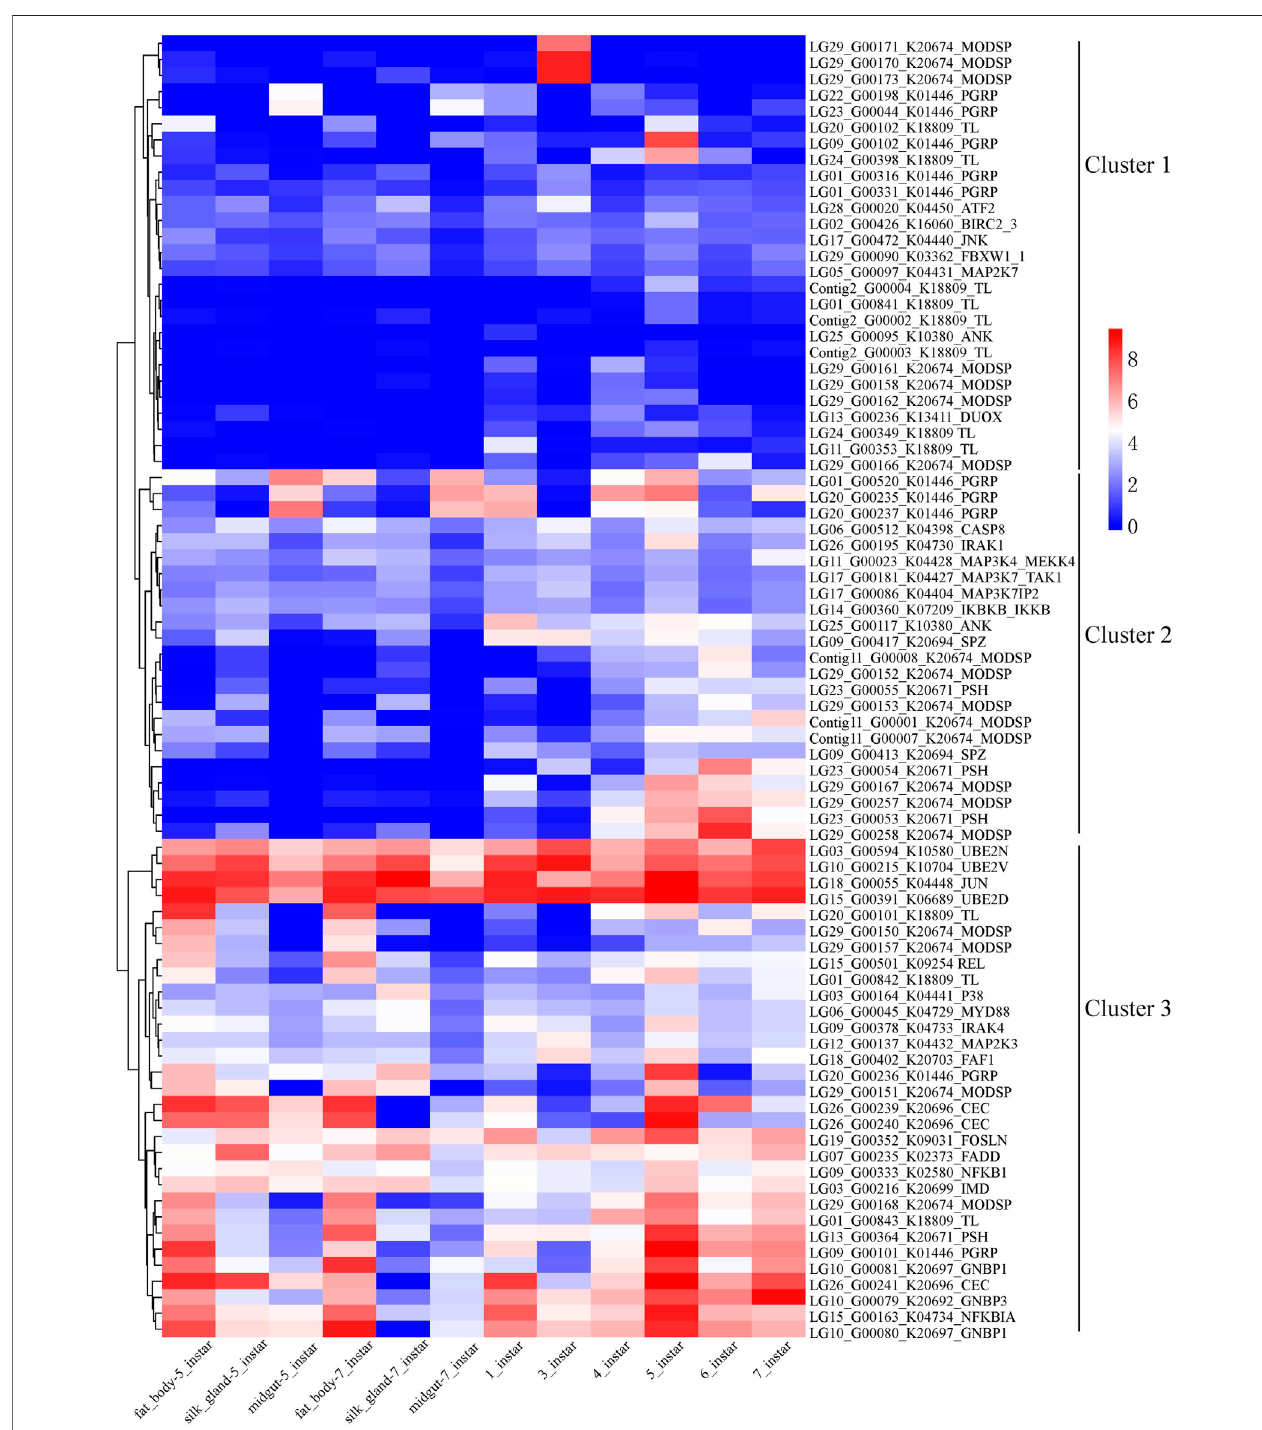
FIGURE 8 | Clustering gene expression pattern of the signi fi cantly expanded genes of the Toll and IMD signaling pathways. Note: Each column represents one sample,eachrowrepresentsonegene.AlltheFPKMvaluesofgenesinthepathwayweretransformedwithlog2,andthennormalizedintoZ-scoresalongtherows.The log2 values were color-coded as shown in the color bar.